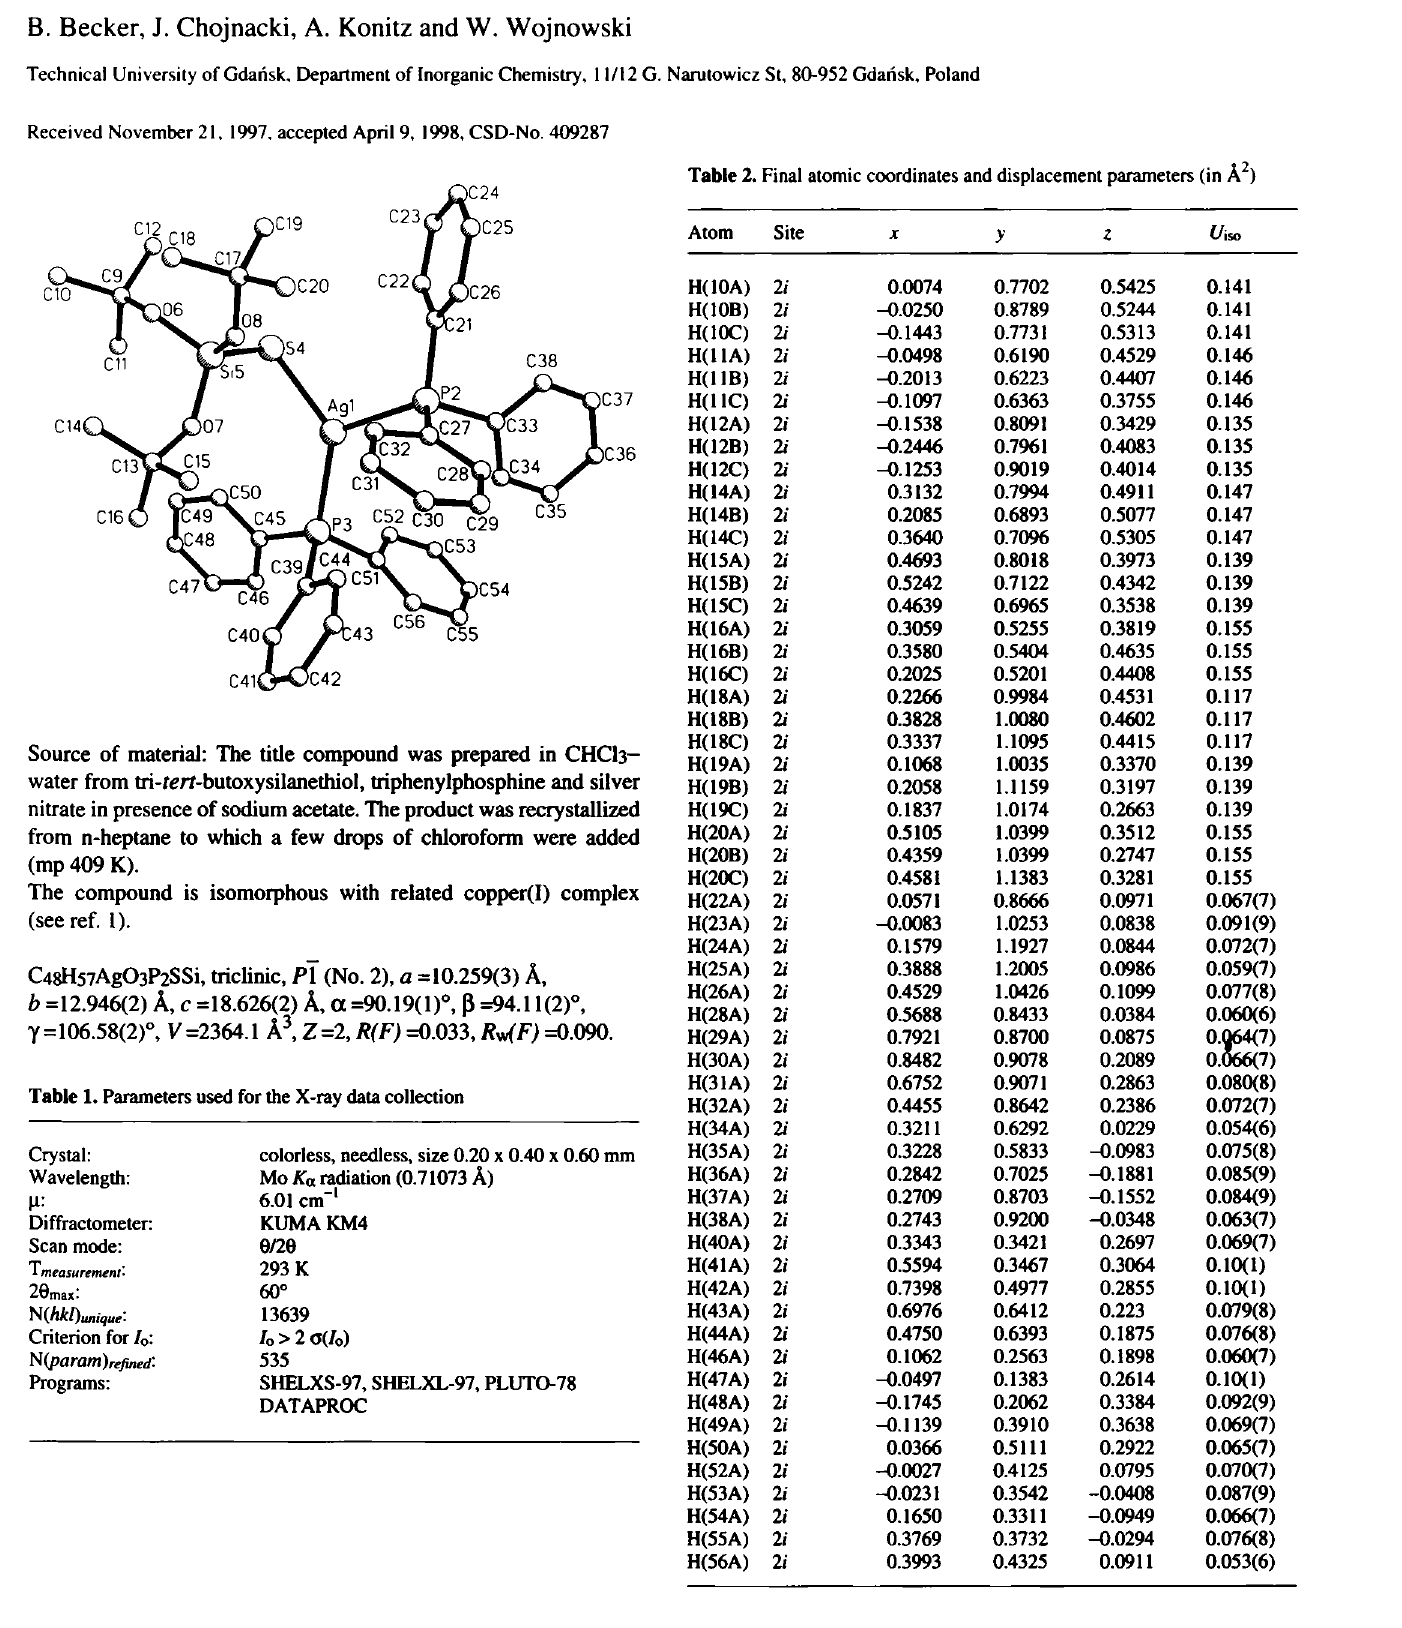
Table 1. Parameters used for the X-ray data collection Crystal: